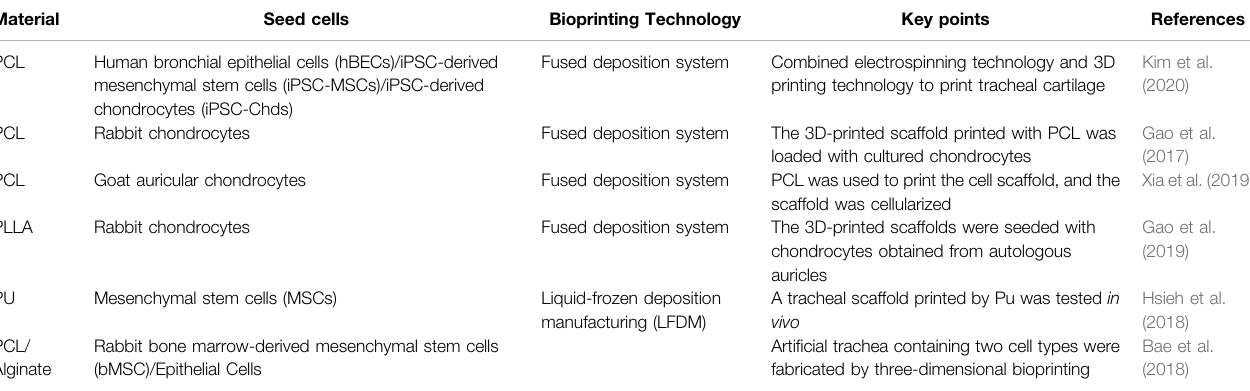
TABLE 3 | Summary of 3D-printed tracheal cartilage.